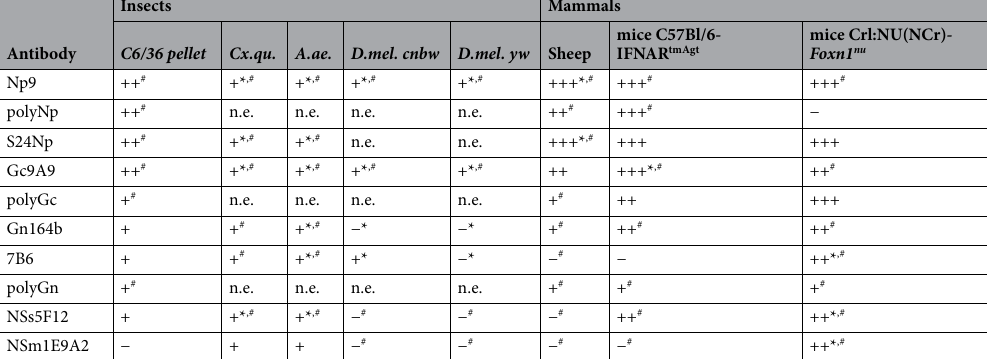
Liver homogenates of RVFV (strain 35/74) infected sheep revealed Ct values ranging from 25.22 to 27.94 indicating the presence of viral genome in the organ. Crl:NU(NCr)- Foxn1 nu mice infected with the highly virulent RVFV strain 35/74 were strongly positive (Ct values ranging from 12.84 to 13.13). C57Bl/6-IFNAR tmAgt mice infected with RVFV (strain MP12) were positive (Ct values ranging from 16.33 to 19.57). Samples of mock- infected sheep and from both mock-infected mouse strains were negative for RVFV-specific nucleic acids. Antigen intensity and dissemination. Immunoreactivity of the different antibodies was characterized in RVFV-infected insects and mammals. A detailed overview about the organ involvement is given in Table 2. C6/36 cell pellet. Nucleoprotein was present as a cytoplasmic, granular signal within moderate numbers (30– 60%) of RVFV-infected C6/36-cells using the antibodies Np9 (Fig. 1), polyNp and S24Np (Table 2). The use of the antibody Gc9A9 yielded moderate numbers (30–60%) of RVFV-infected C6/36 cells with the same reaction pattern as seen for anti-nucleoprotein antibodies (Fig. 2). All remaining antibodies directed against glycopro- teins (polyGc, Gn146b, 7B6 and polyGn) labeled low numbers (< 30%) of RVFV-infected C6/36 cells with a cytoplasmic, granular reaction. Antigen was present in low numbers of RVFV-infected cells (< 30%) with an intracytoplasmic and nuclear, granular reaction using NSs5F12 (Fig. 3), while NSm1E9A2 did not show a reli- able reaction in virus infected C6/36 cells. Non-infected cells presented a low to moderate background for Np9, Gc9A9 and all polyclonal antibodies. In contrast, non-infected controls were free of labeling as well as back- ground staining using remaining monoclonal antibodies (see Supplementary Fig. S1-S22 online).